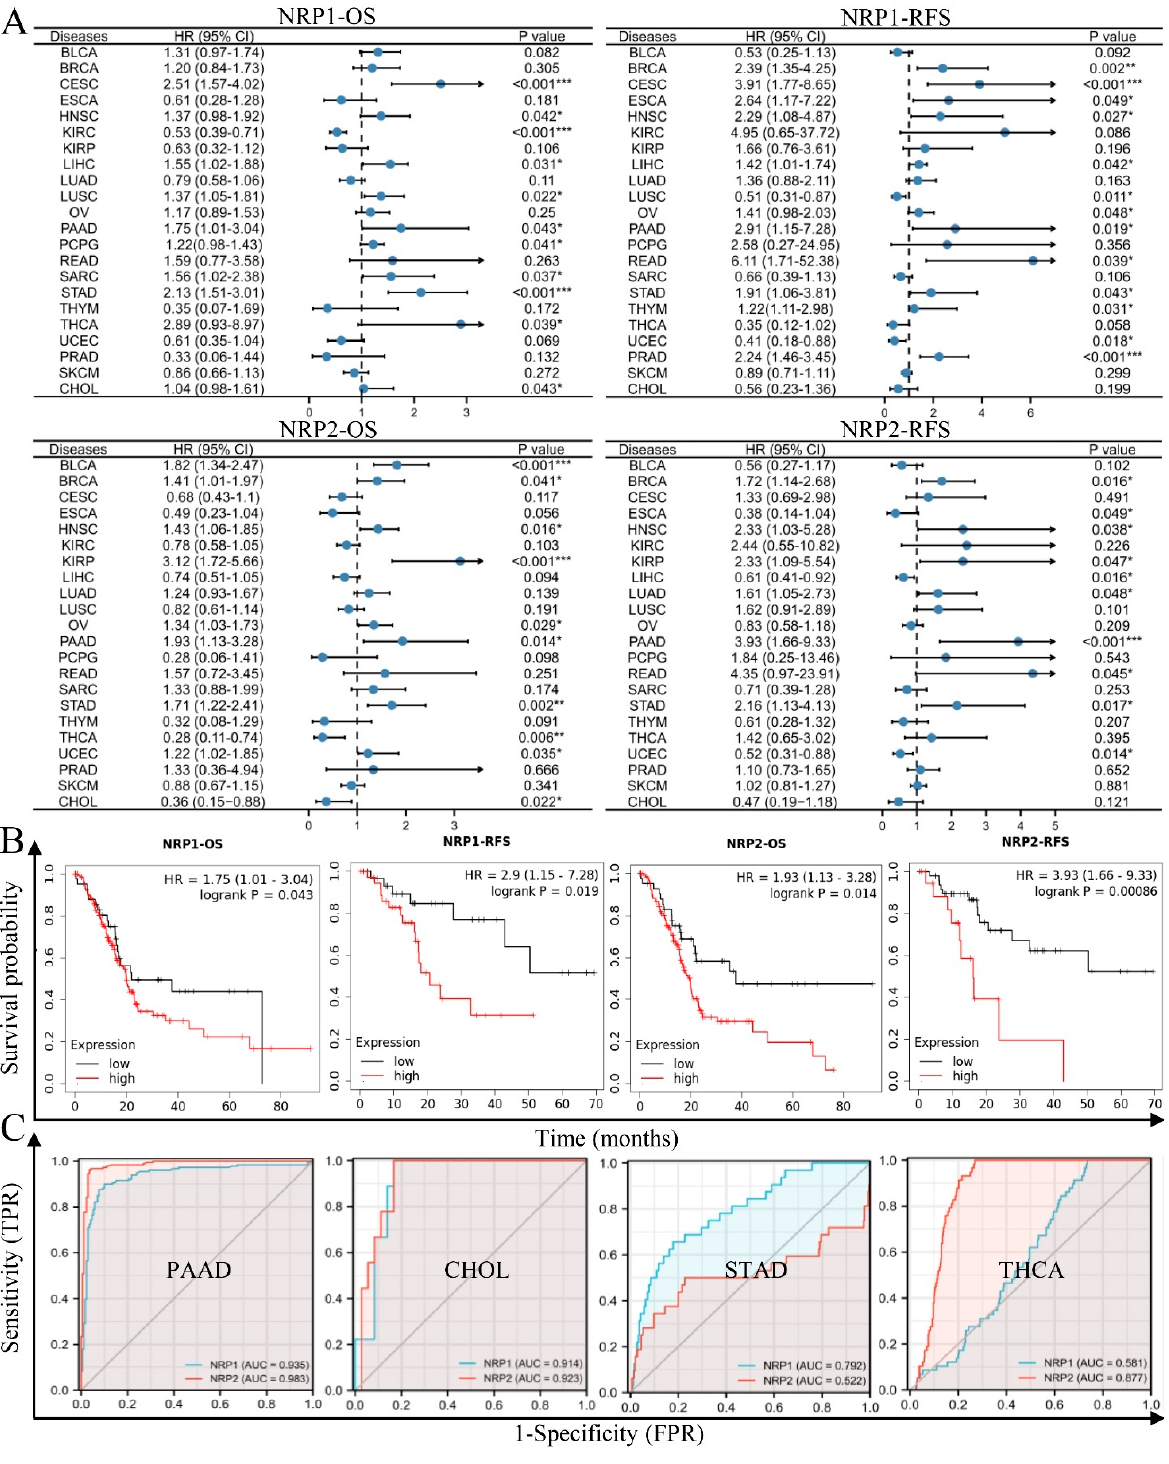
Figure 3. The prognostic and diagnostic significance of NRPs. ( A , B ) Log-rank test was used to analyze the relationship between NRP expression and OS, as well as RFS in pan-cancer, and the results are presented as forest plots ( A ); in PAAD, the results are presented as Kaplan–Meier plots ( B ). ( C ) Receiver operating characteristic (ROC) curve analysis evaluating the performance of NRPs for PAAD, CHOL, STAD and THCA diagnosis. The median value of NRP expression was taken as the cut-off value, and the patients were grouped into high- or low-expression groups. * p < 0.05; ** p < 0.01 and *** p < 0.001.